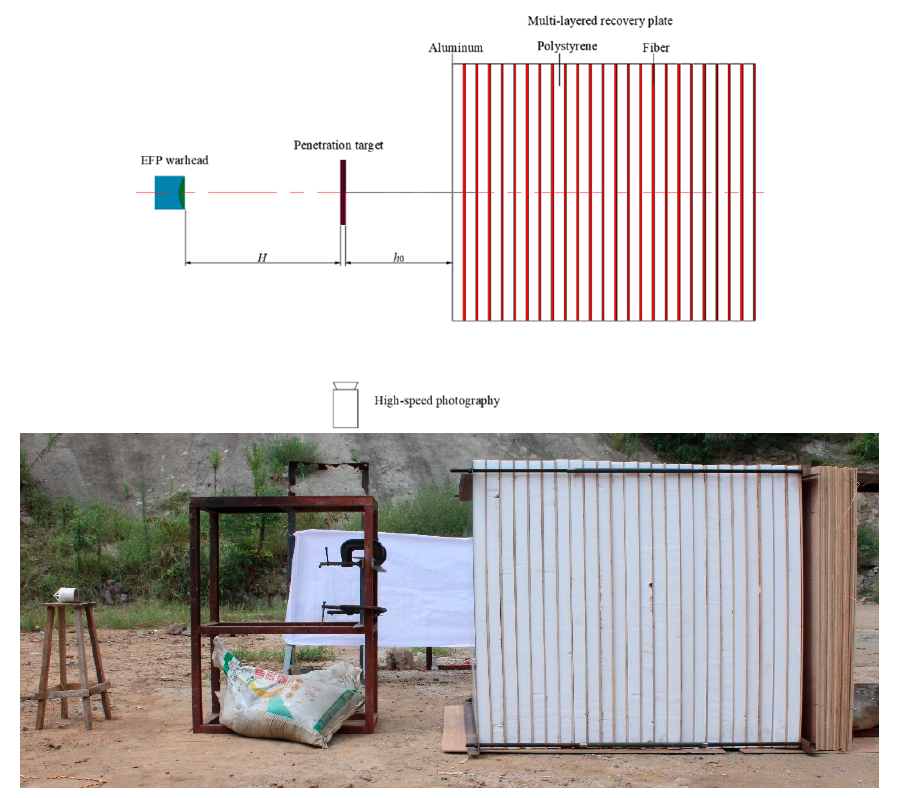
Figure 3. Experimental setup.